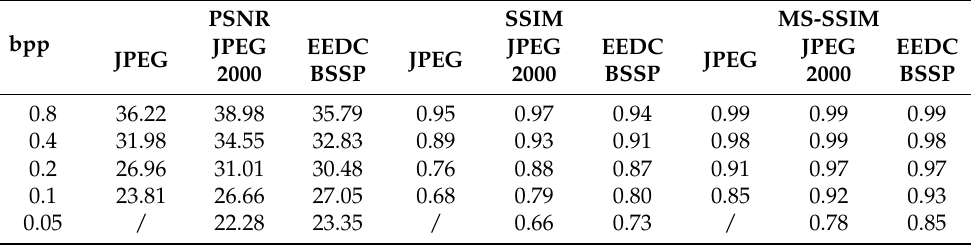
( a ) ( b ) ( c ) Figure 17. Comparative overview of reconstructed images for image pills ranging from 0.8 bpp ( top row ) to 0.05 bpp ( bottom row ). Compression methods: ( a ) JPEG, ( b ) JPEG 2000, and ( c ) EEDC-BSSP. Table 16. Results of the PSNR, SSIM, and MS-SSIM metrics for image mask